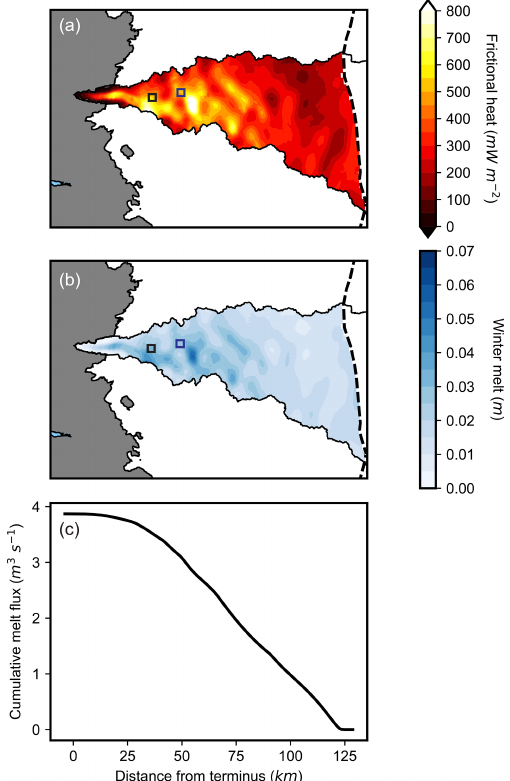
Figure 7. Basal ice melt during winter 2017–2018 across the Isun- nguata Sermia basin based on satellite velocity and model assump- tions described in the text: (a) basal frictional heat rate averaged over the winter period (October through April); (b) total basal melt- water generated during the winter months; (c) top-to-bottom accu- mulation of basal meltwater generation rate averaged over the win- ter period. Basal meltwater is integrated as a function of inland dis- tance, irrespective of potential routing pathways.